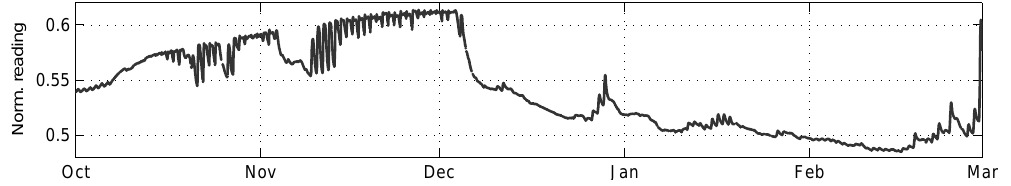
Fig. 12. Normalized sensor reading of the EnviroSmart probe at 20cm depth (M1).